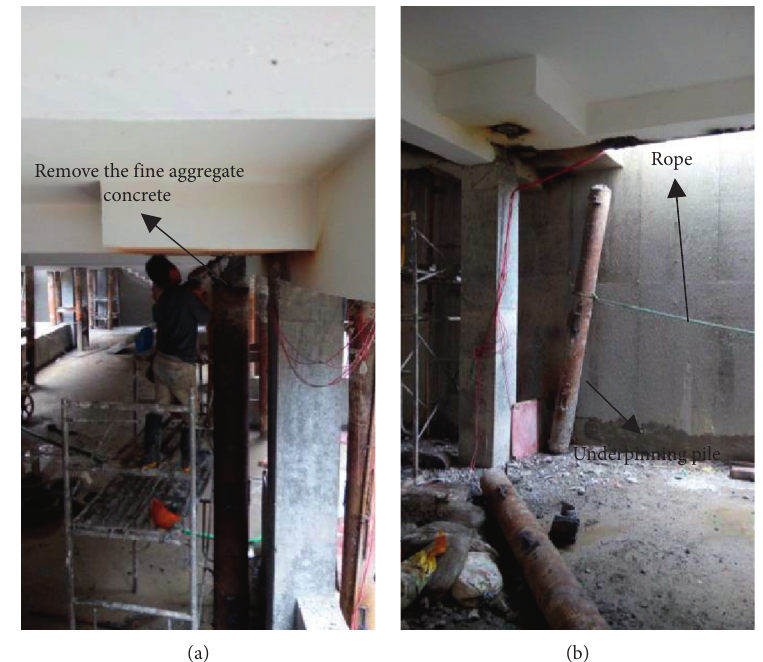
Figure 11: Cutting off the underpinning pile: (a) cutting off the pile; (b) pulling down the pile.